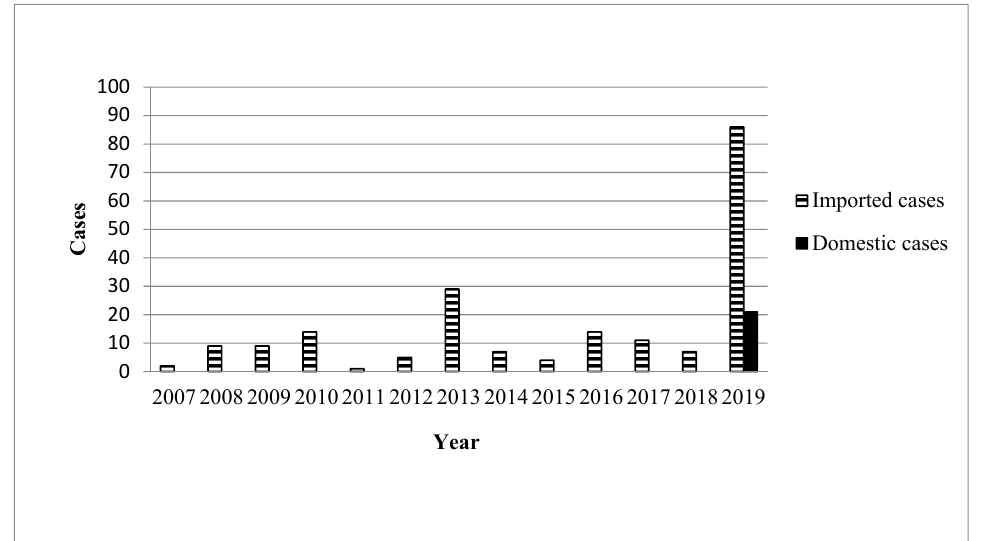
Figure 1. Yearly distribution of chikungunya associated with domestic and imported patients during 2007 and 2019.